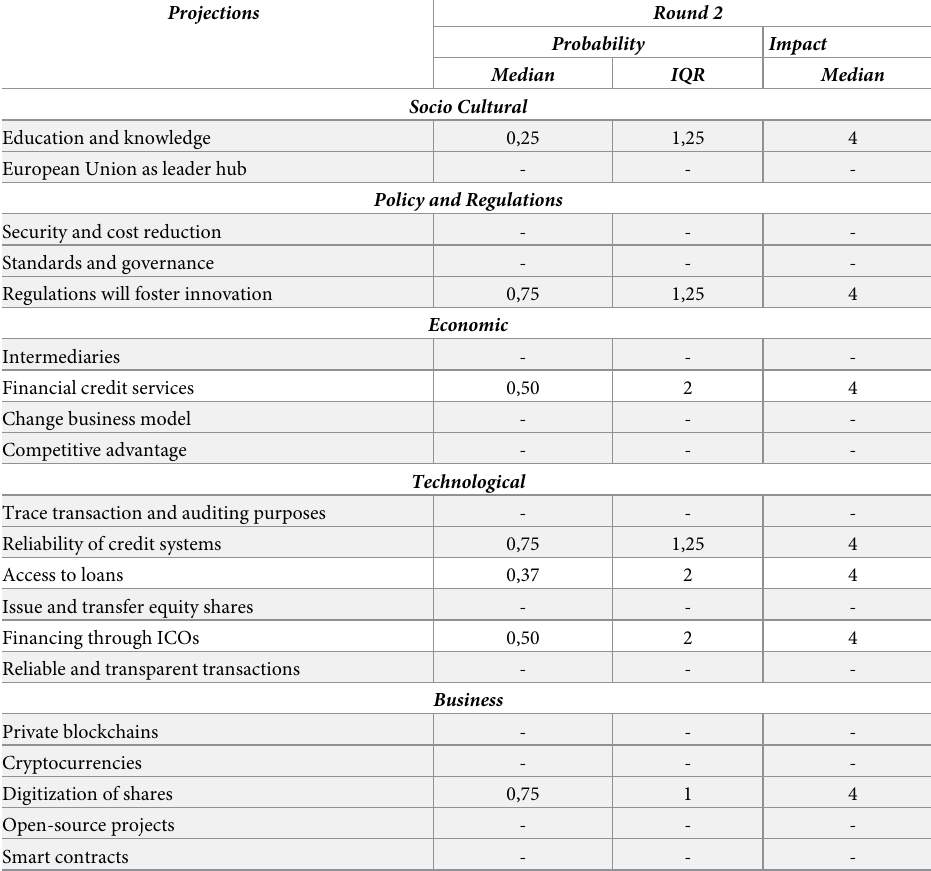
Table 4. Central tendency measures for the second round of